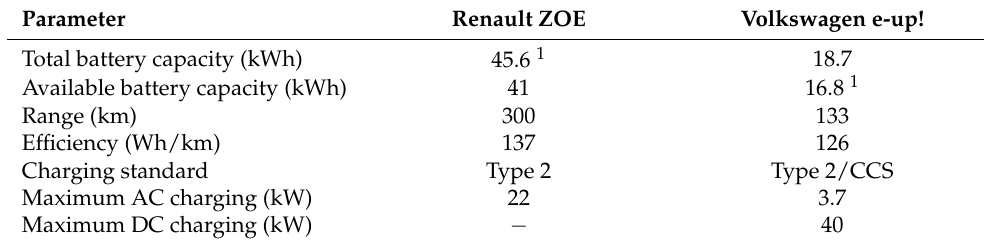
Table 1. Parameters of electric cars at Ballen